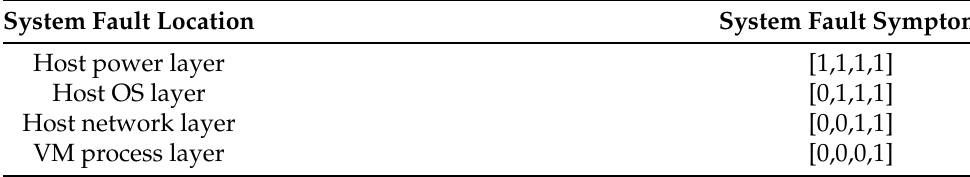
Table 7. Fault-symptom table of the system under testing. VM: virtual machine.